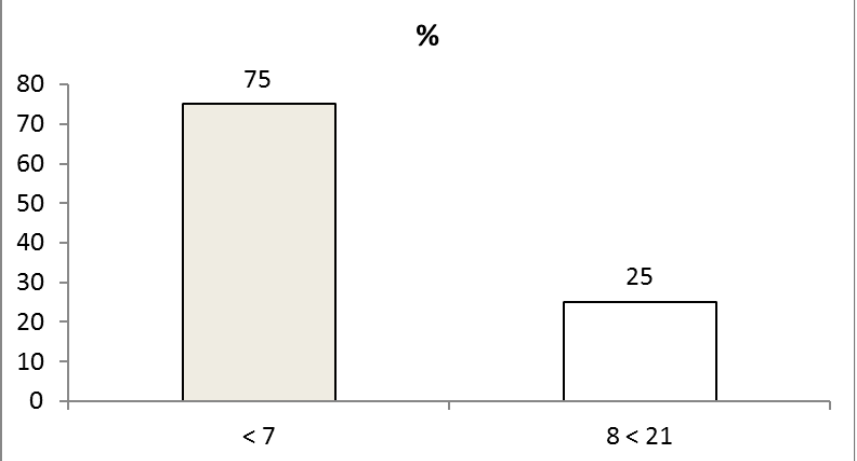
Figure 9. T ime required (days) of rehabilitation of injuries